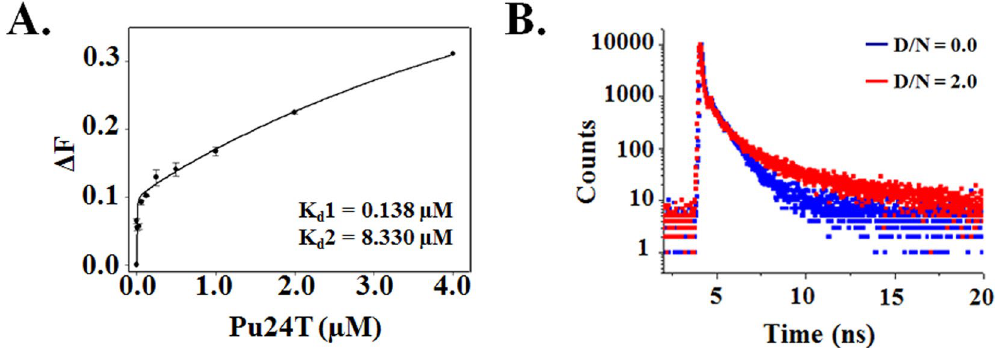
Figure 2. Steady state and time resolved fluorescence studies. ( A ) Fluorescence titration curve of Quercetin as a function of Pu24T concentration. Solid lines represent fit according to the ligand binding two site saturation model. Value of Binding constant(s) (K d ) are indicated at the bottom right side of the plot. ( B ) Fluorescence life time decay curve of 40.0 µ M free Quercetin (Blue) and its complex with Pu24T DNA at D/N ratio = 2.0 (Red).